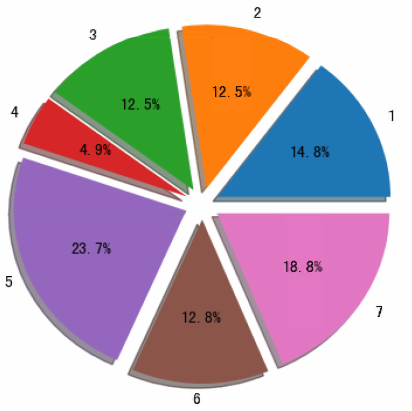
Figure 5. Civil aviation radar signal of receiving and processing system.